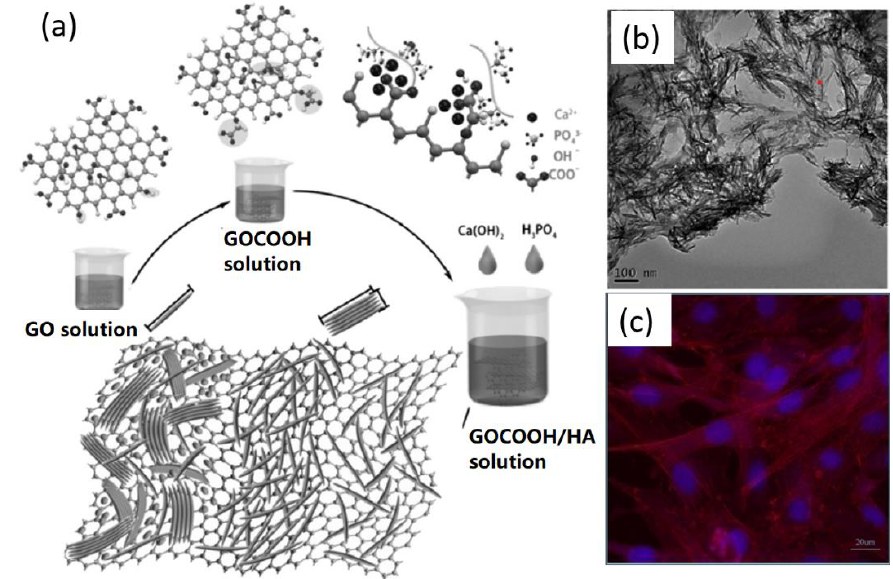
Figure 7. Biomimetic GO-HA nanohybrids for cell adsorption and growth: ( a ) Biomimetic synthesis of HA on GO-COOH substrate; ( b ) TEM image of GO-HA nanohybrids, and ( c ) Fluorescence image of GO-HA/silk fibroin (SF) scaffold after cell growth. Reproduced with the permission from ref. [75]. Copyright 2017 Elsevier Ltd.